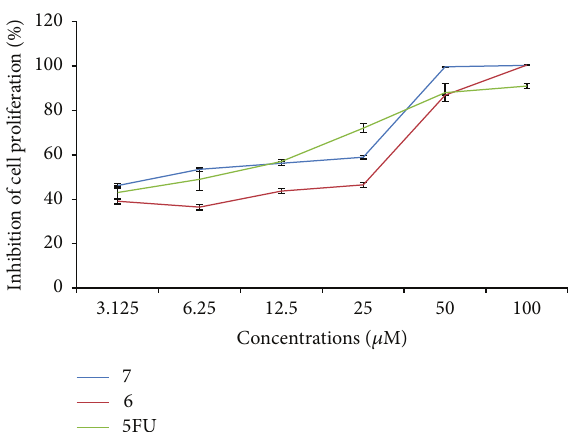
Figure 4: Antiproliferation effect of test compounds on HCT 116 was assessed by MTT-assay. The figure depicts dose-dependent activity of test complexes ( 6 - 7 ). The activity of silver complexes was found significant, whereas respective salts ( 4 - 5 ) were found inactive (values are represented as mean ± SD n = 3).